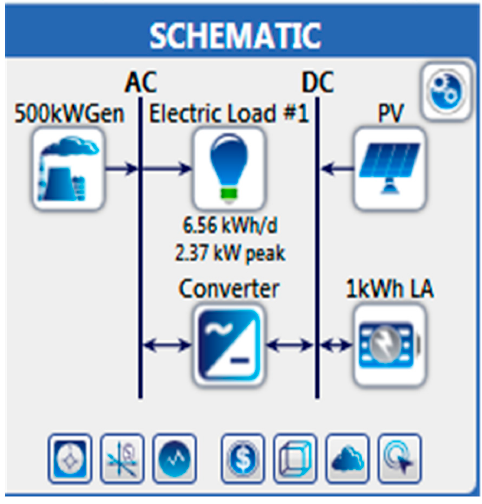
Figure 9. Hybrid energy system with diesel generator and battery. Table 3. Cost Summary.